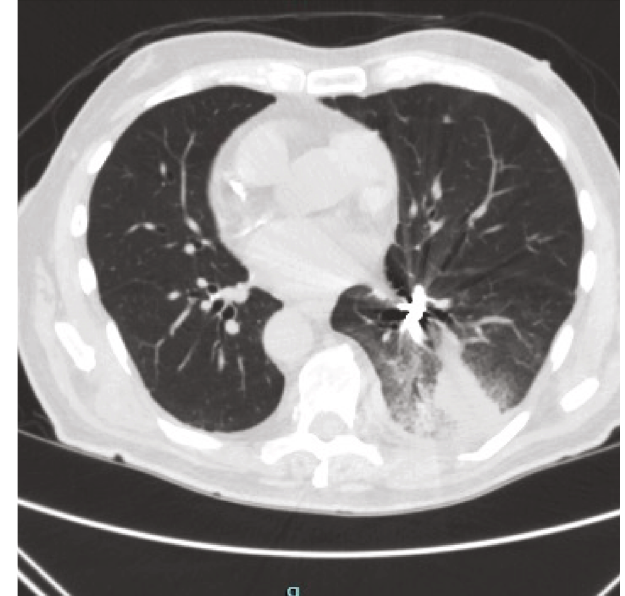
Figure 3: CT scan chest axial section (lung window) with a metallic object in